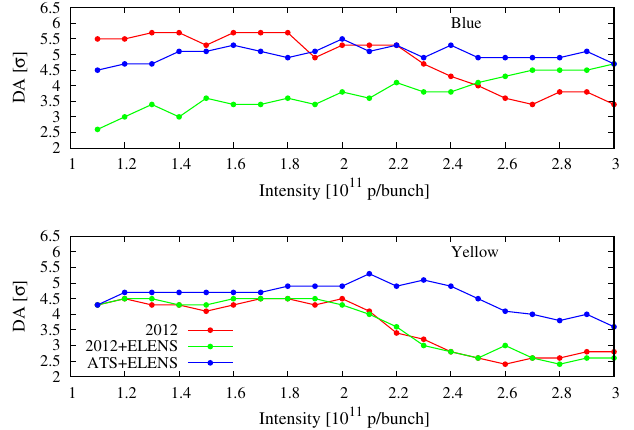
for the Blue hori- x;y